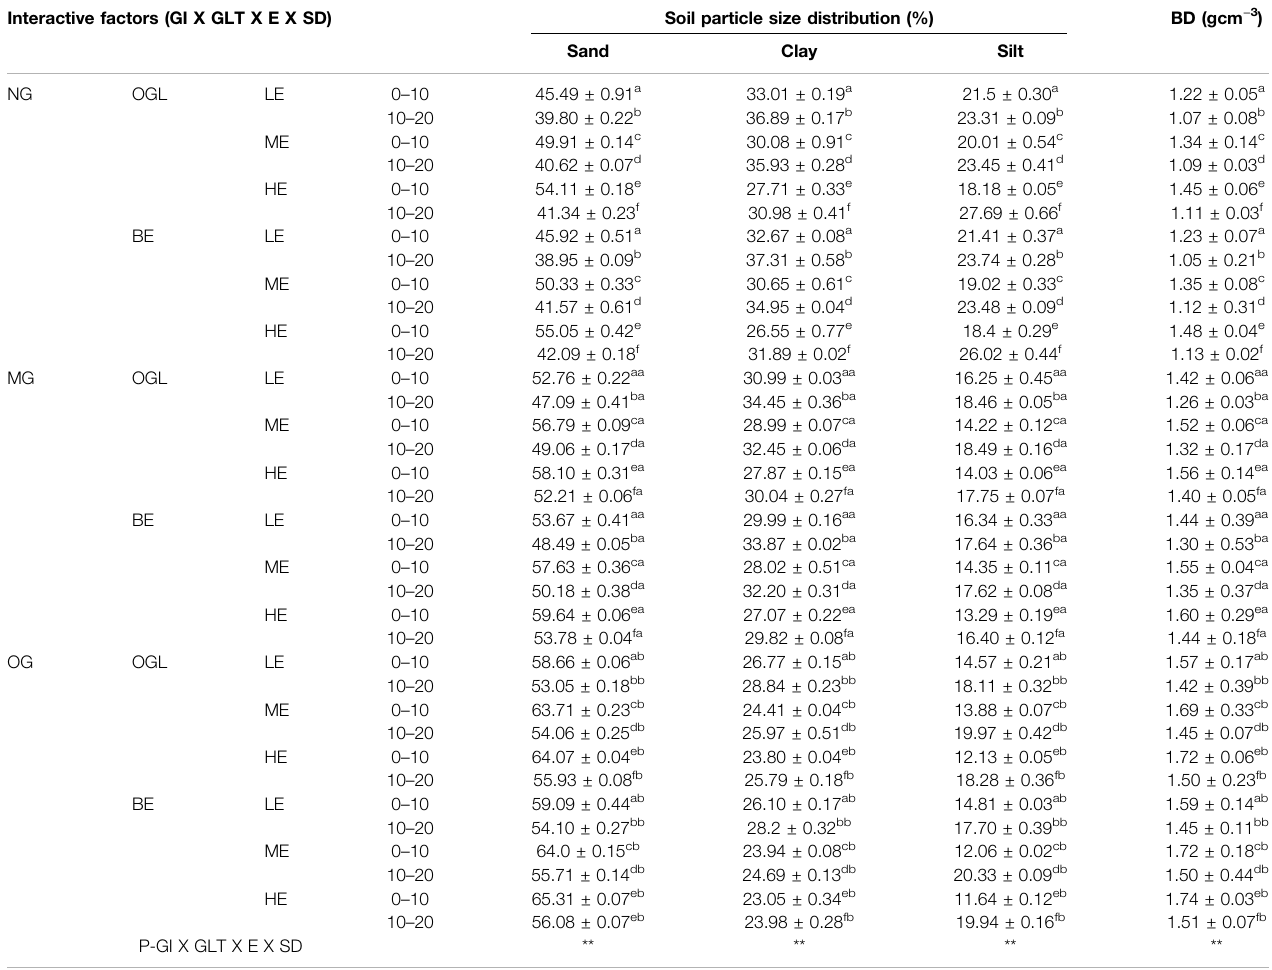
TABLE 3 | Mean ( ± SE) value of soil physical particle size distribution under the interaction effects of grazing intensity with grazing land type, elevation, and soil depths. Interactive factors (GI X GLT X E X SD) Soil particle size distribution